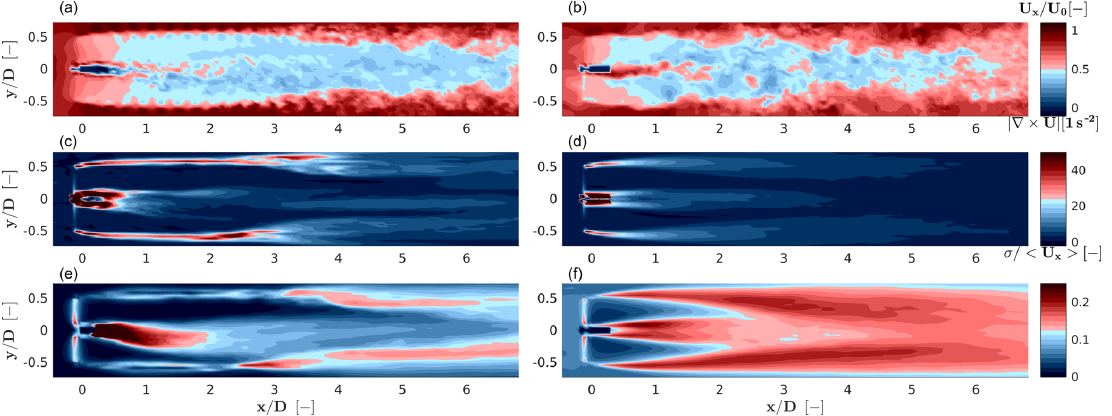
Figure 10. Instantaneous streamwise speed component u x /U 0 (a, b) , vorticity (cid:104)∇ × u (cid:105) (c, d) and turbulence intensity σ/ (cid:104) u x (cid:105) (e, f) . At left, low-turbulence case; at right: moderate-turbulence